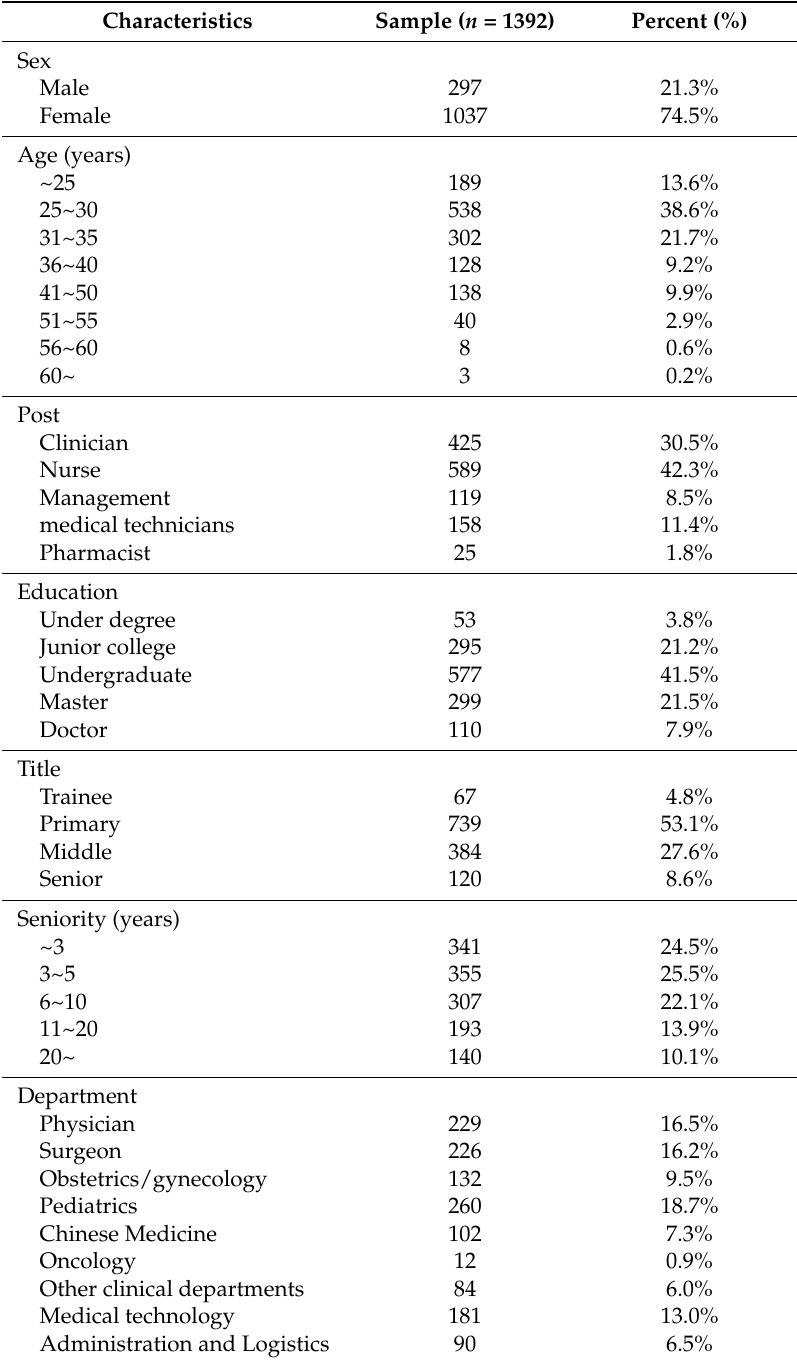
Table 2. Demographic characteristics of the sample of healthcare